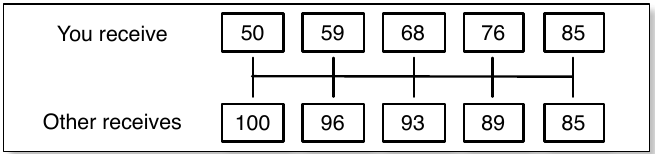
Figure 1. One of the six resource allocation tasks of the SVO Slider Measure as used in this study. In each task, the DM chooses between five own-other payoff